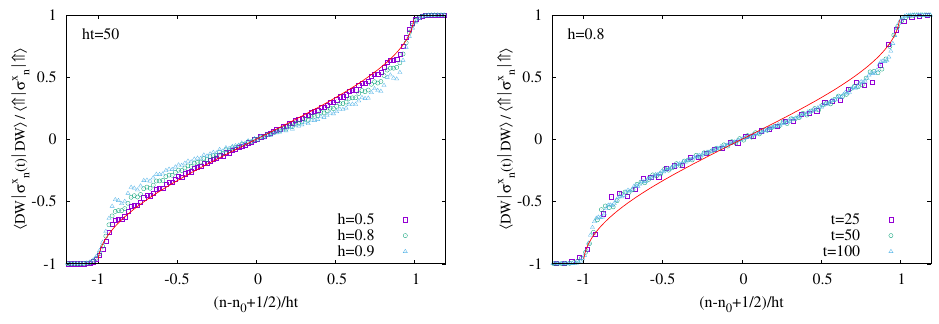
Figure 4: Normalized magnetization profiles vs. rescaled distance for DW excitation in a chain of length N = 200. Left: the profiles for fixed ht = 50 and various values of h do not collapse. Right: the profiles for h = 0.8 and various times collapse onto each other. The solid lines show the semi-classical result, Eqs. (26) and (32), for the JW excitation for